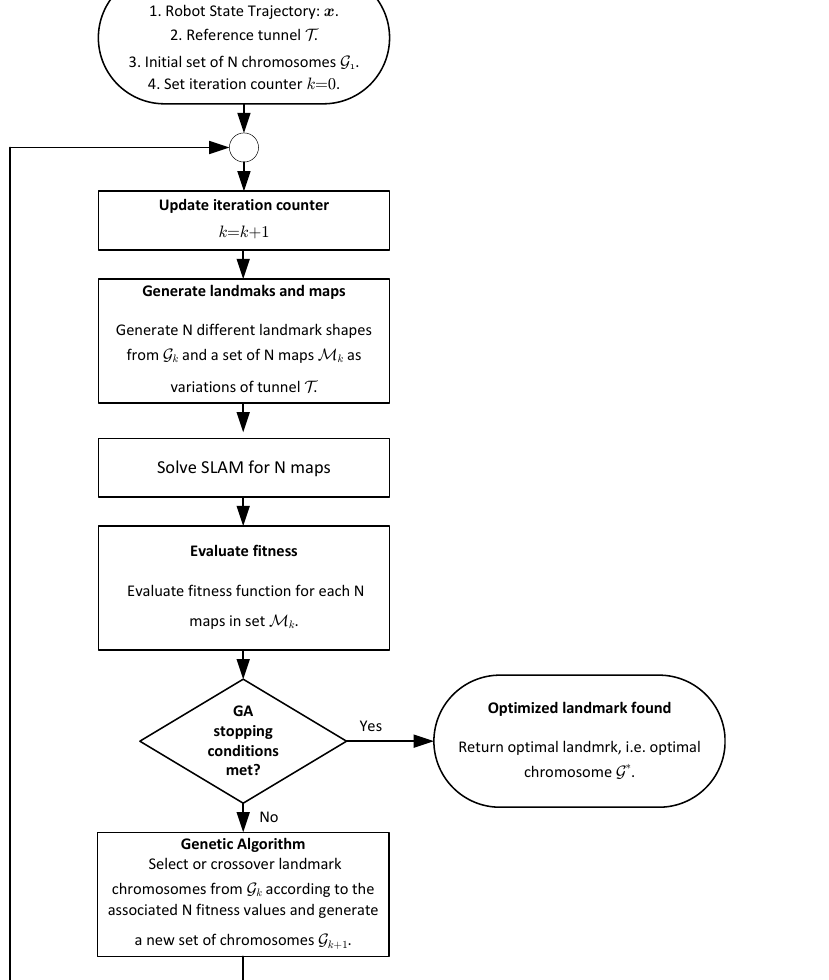
Figure 4. Implemented search scheme for optimized landmark geometries and